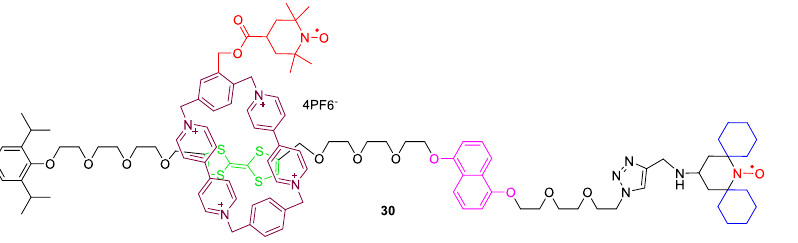
Figure 4. Structure of [2]rotaxane 30 bearing two different nitroxide units, two redox-active tetrathiafulvalene (TTF) groups and the 1,5-dioxynaphthalene (DAN) component.